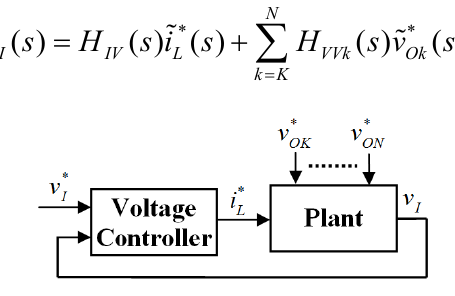
Figure 17. Input voltage side closed loop